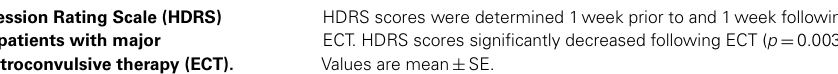
HDRS scores were determined 1week prior to and 1week following ECT. HDRS scores significantly decreased following ECT ( p = 0.003). Values are mean ±